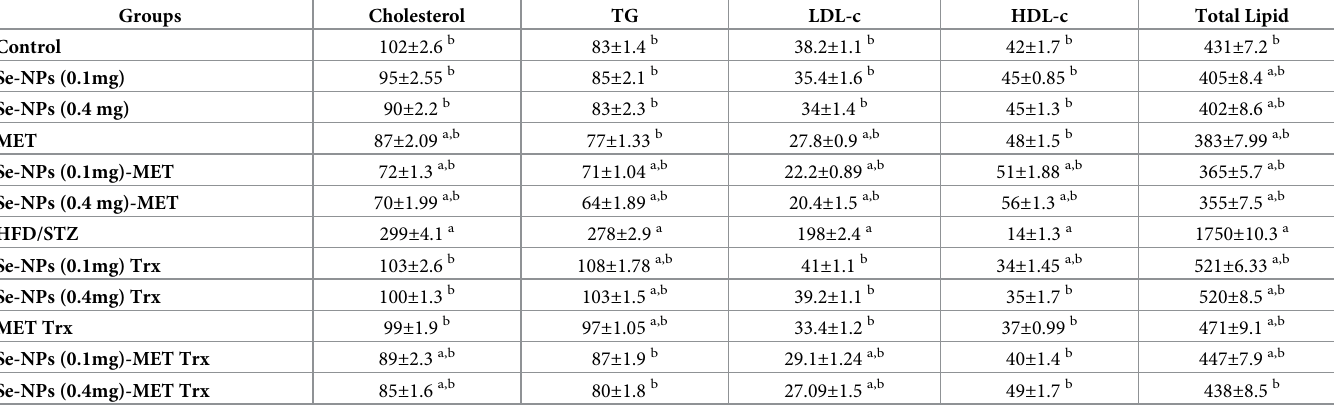
Table 5. The comparison of the effect of Se-NPs, MET monotherapy, and combined therapy on serum Lipid profile TC, TG, LDL-c, HDL-c, TG, total lipid of the studied groups.